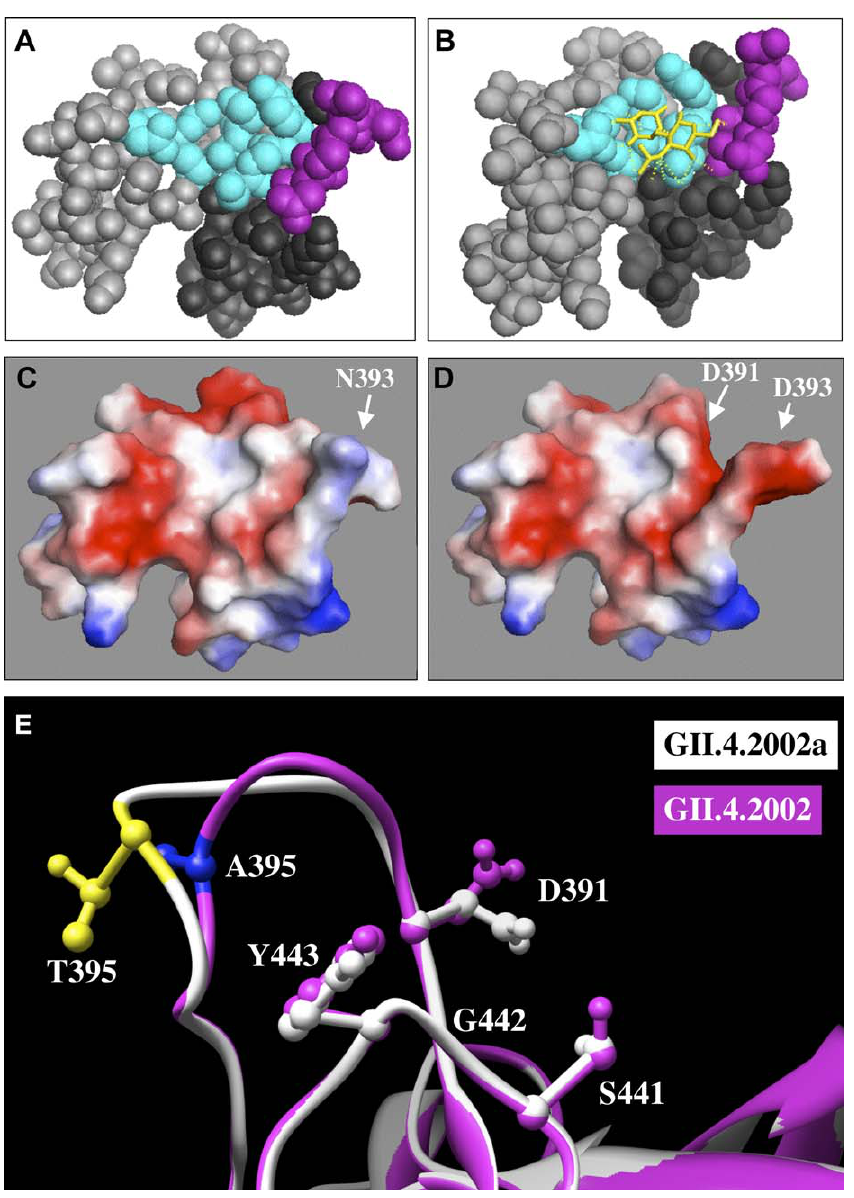
Figure 5. Subtle Changes in Interaction Site 2 May Govern HBGA Carbohydrate Binding (A) Two identical RBDs are formed upon dimerization of two capsid proteins (gray, chain A; black, chain B), with each RBD containing two sites important for HBGA carbohydrate binding. Site 1 (cyan) directly interacts with the ligand, while site 2 (purple) provides weak, long-range interactions that may regulate receptor specificity. (B) In VA387, B-trimer (yellow) binds to site 1 by a strong hydrogen bond network. (C and D) Electrostatic differences between RBDs of VA387 (C) and Rosetta-predicted RBD of GII.4–1987 (D) show that changing an Asp at 393 present in GII.4–1987 to Asn393 found in the GII.4–1997 cluster significantly alters interaction site 2. Repulsion between Asp393 and a conserved Asp391 forces the side chain of Asp393 away from the pocket. These alterations likely lead to differences in binding between GII.4–1987 and the GII.4–1997 cluster. (E) Molecular remodeling by mutation in GII.4–2002 cluster. Homology models for the P domain of GII.4–2002 and GII.4–2002a were generated with Modeller using the coordinates from PDB accession number 2OBT (in VA387 from cluster GII.4–1997), and the structures were superimposed upon one another and analyzed for differences. The predicted structures had an RMSD of 0.201 A˚, with the only change in the structures occurring at position 395, where GII.4–2002 has an Ala residue and GII.4–2002a encodes a Thr. The addition of Thr at position 395 remodels interaction site 2, increasing the pocket by 1.111 A˚. We predict that this subtle change in site 2 will be sufficient to alter HBGA